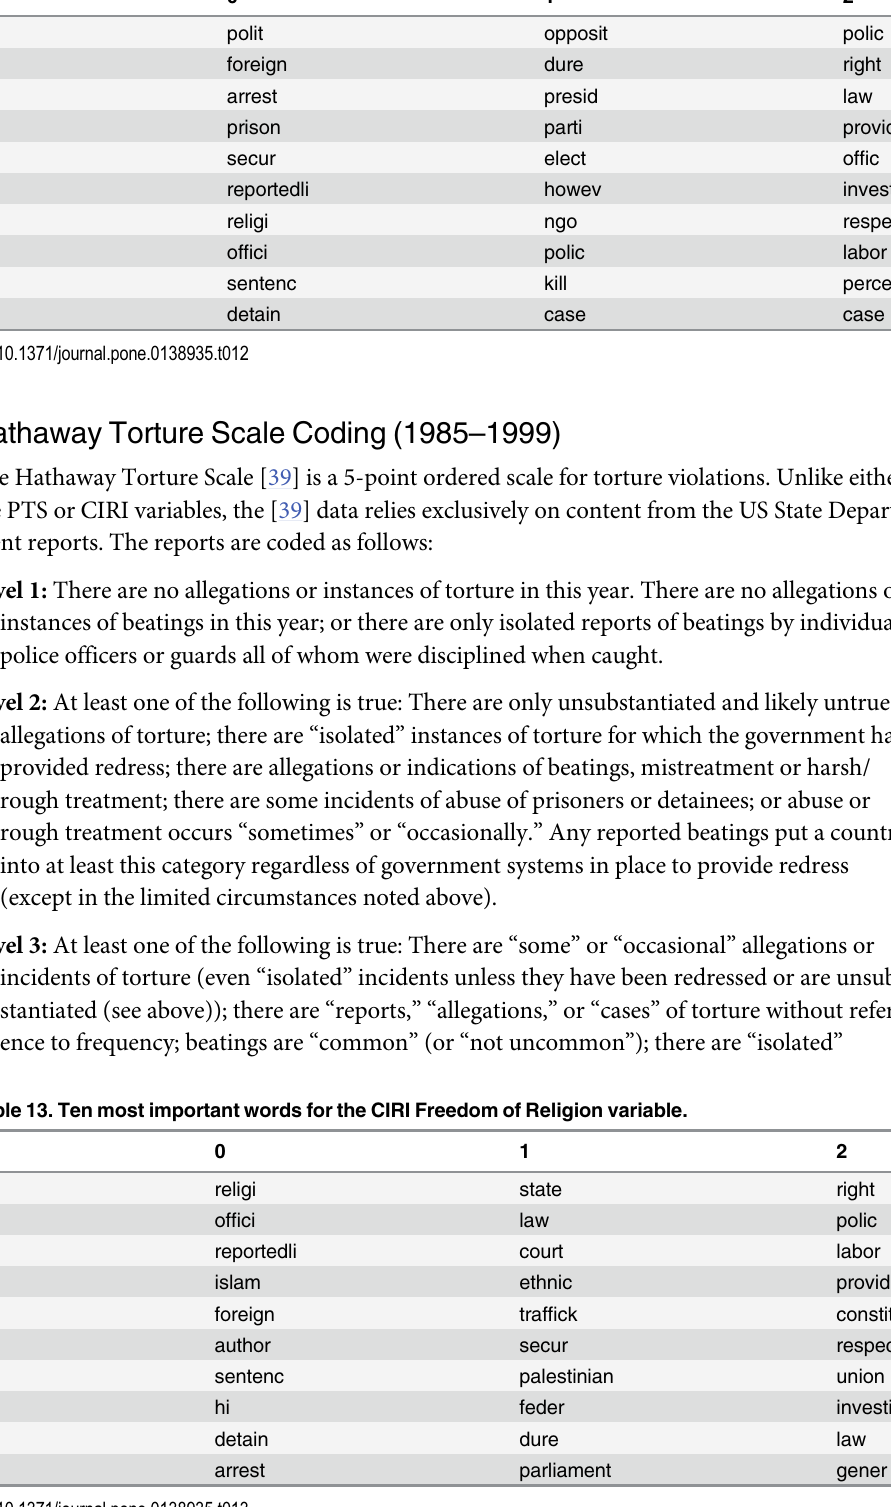
Table 12. Ten most important words for the CIRI Electoral Self-determination variable. 0